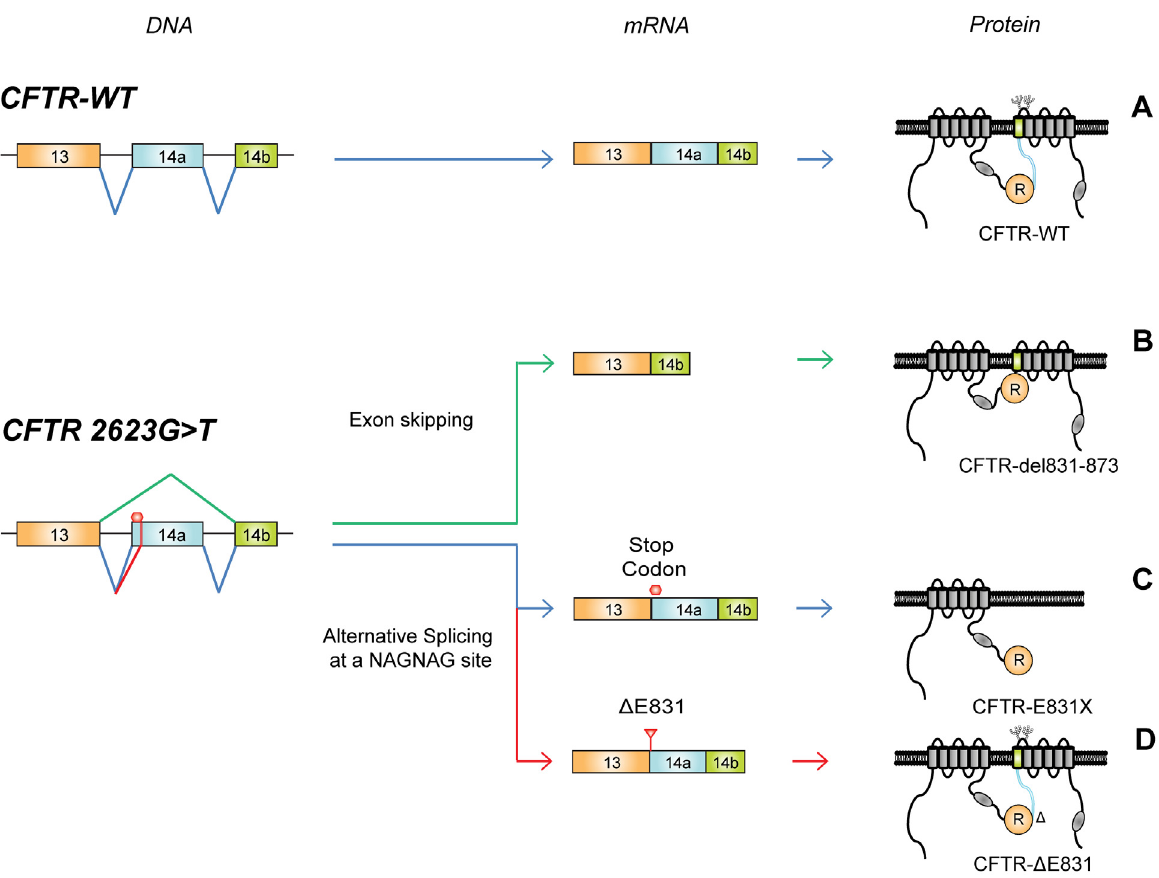
Figure 4. A single nucleotide substitution generating three distinct proteins. (A) CFTR-WT processing from DNA to protein. The R domain is encoded by exon 13 (orange), whereas exon 14a encodes the region linking the R domain to the seventh transmembrane segment (blue). The two glycosylation sites are indicated between the seventh and eighth transmembrane segment. The 2623G . T mutation located at the first nucleotide of exon 14a induces skipping of exon 14a producing CFTR-del831-873 (B). Alternative splicing at the NAGNAG site generates mRNA including the stop codon encoding truncated CFTR-E831X (C), and mRNA lacking the stop codon leading to CFTR- D E831 (D).